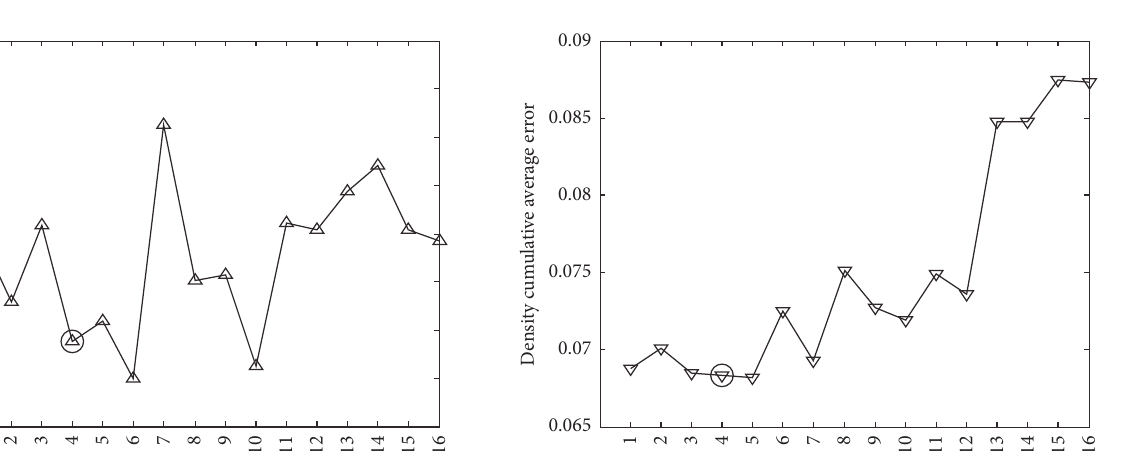
Figure 17: Relative errors of density under 16 situations; the base density is 𝜌𝜎 3 = 0.81